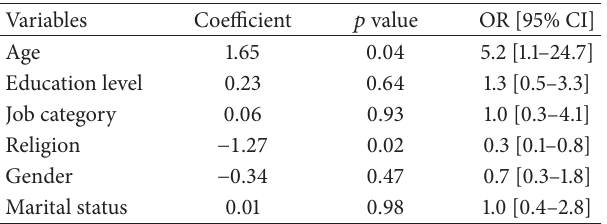
Table 4: HIV testing result from VCT versus sociodemographic variables.